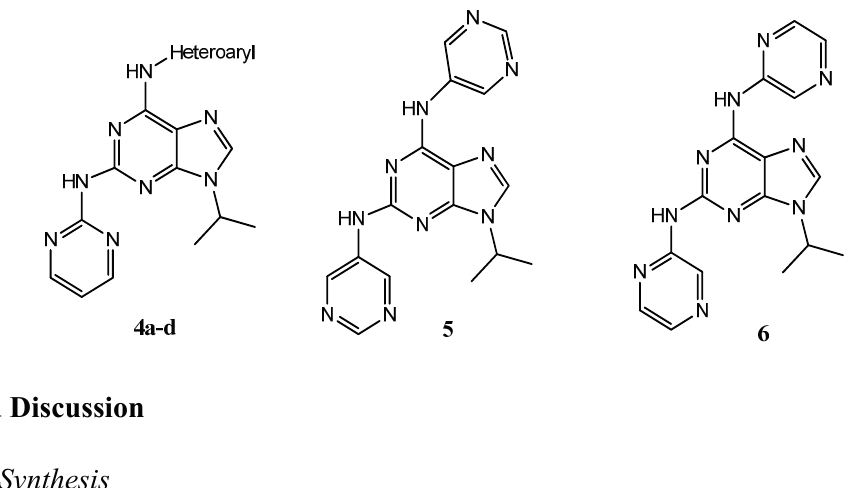
Figure 2. General structure for the newly-synthesized